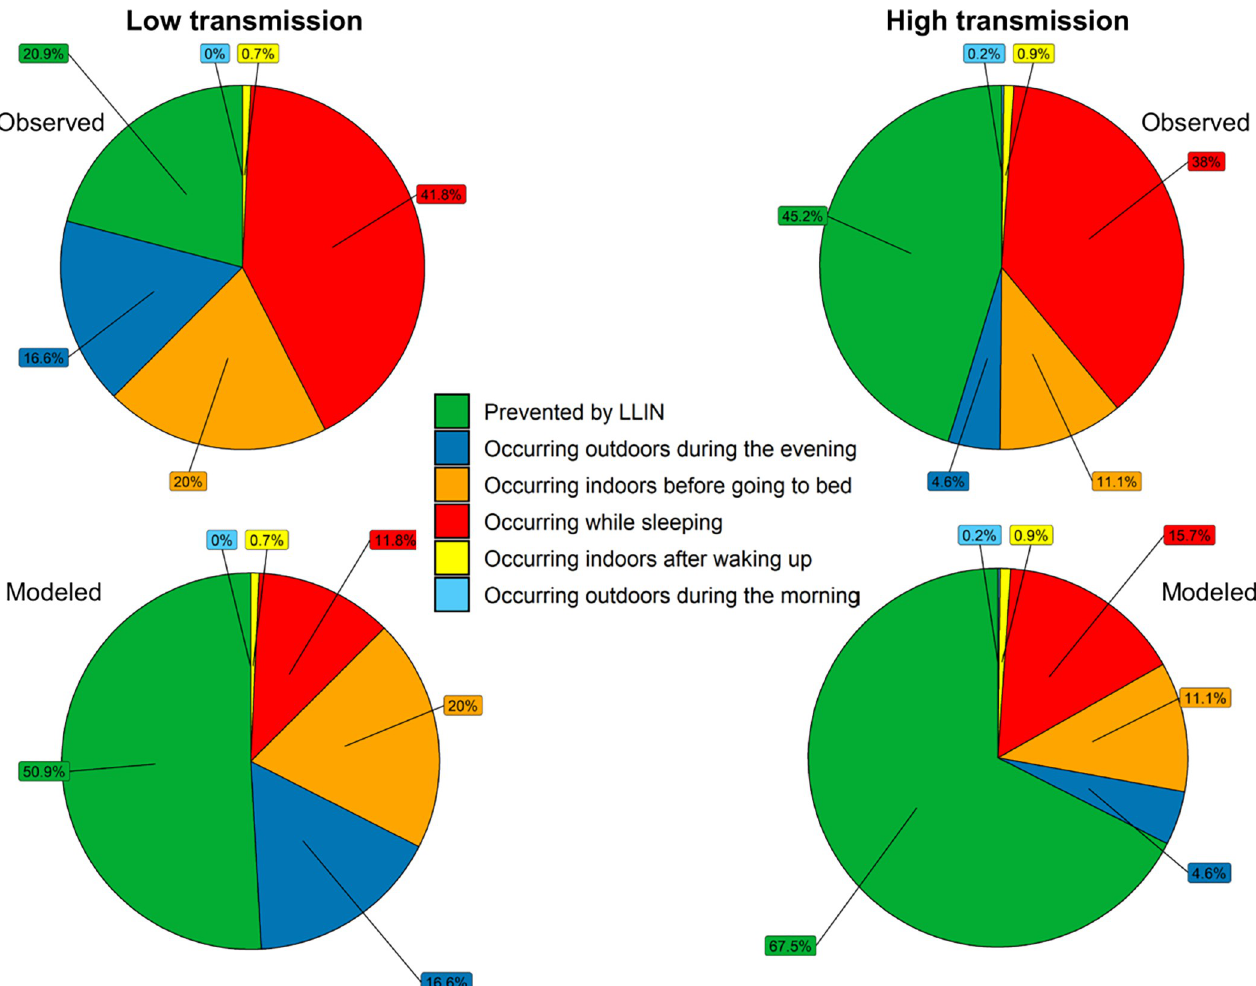
Fig 4. The proportion of exposure to host-seeking mosquitoes prevented by the personal protection of LLINs and the distribution of the unprevented exposure across the five different environments. The proportion of residual exposure to host-seeking vectors are provided at the observed (top) and modeled (bottom) net use (assuming all residents use a net while in bed). Green: exposure prevented by LLINs, dark blue: residual exposure outdoors before going indoors, orange: residual exposure indoors before going to bed, red: residual exposure while in bed, yellow: residual exposure indoors after getting up, light blue: residual exposure outdoors after leaving the house